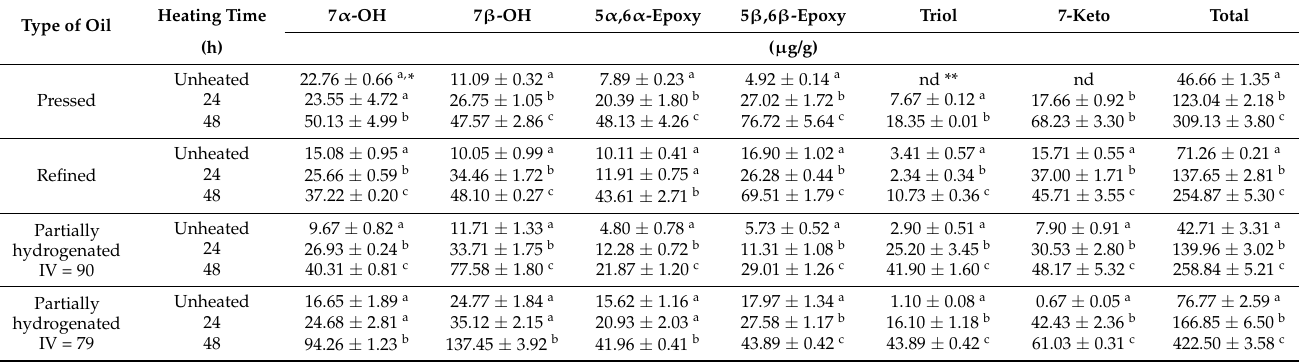
Table 4. Influence of heating time on campesterol oxidation products’ contents in rapeseed oil heated at 170 ± 5 ◦ C. Type of Oil Heating Time